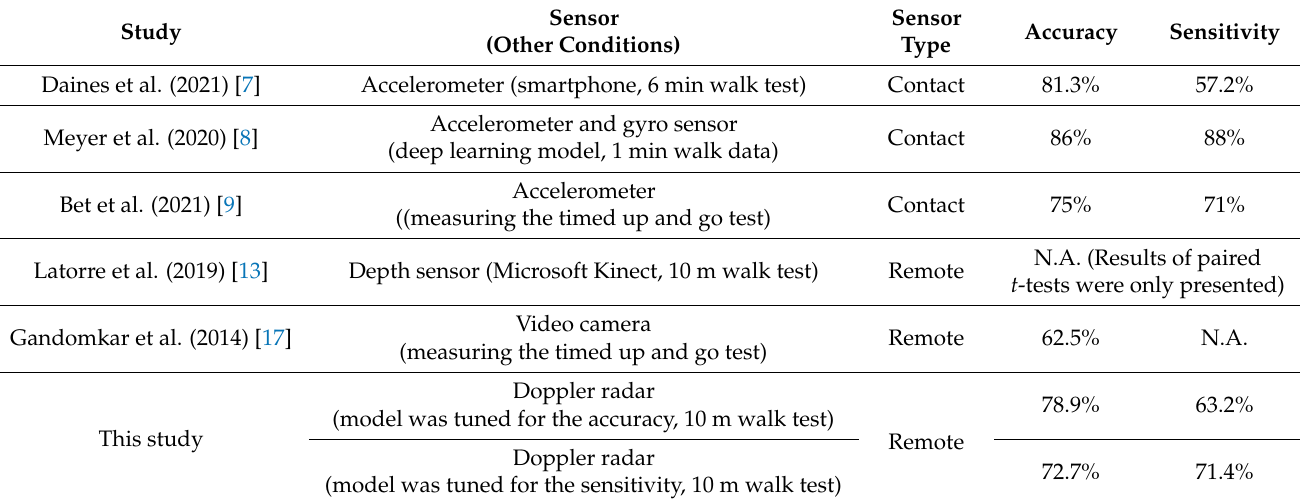
Table 5. Comparison of conventional and present studies on the faller